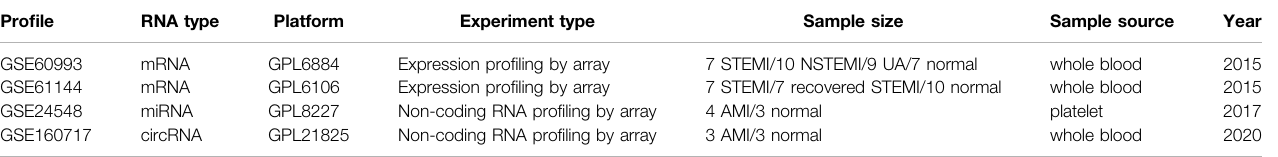
TABLE 1 | Basic information of 4 AMI microarray datasets. Pro fi le RNA